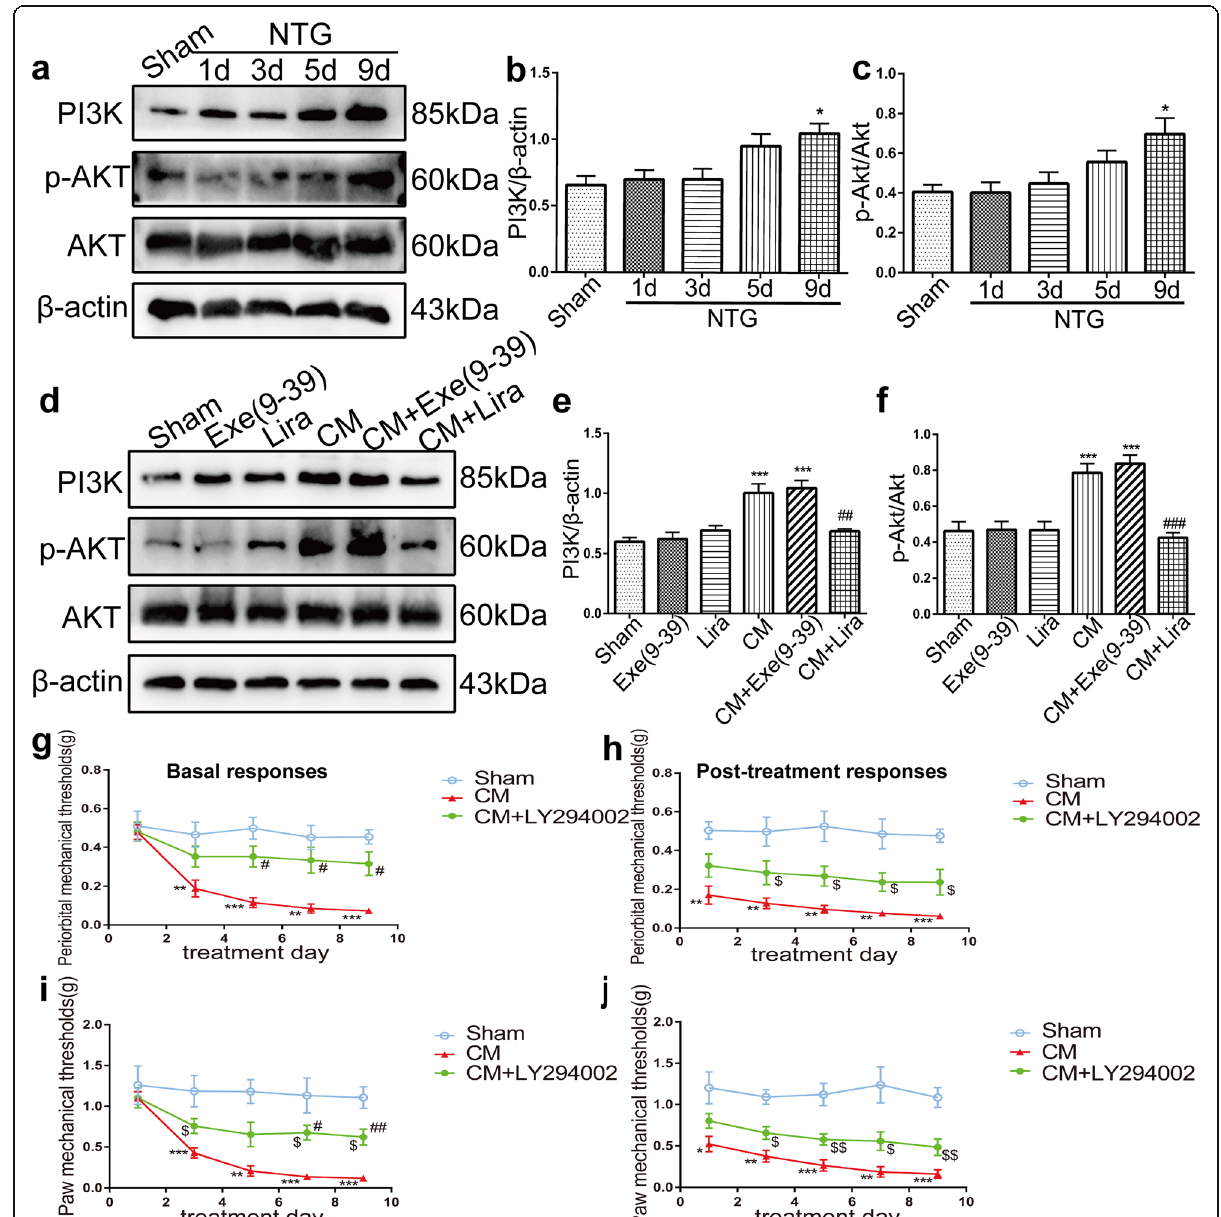
Fig. 8 Inhibition of PI3K/Akt pathway activity, which is regulated by GLP-1R, prevented NTG-induced allodynia. a-c Representative immunoblots of PI3K and p-Akt (Ser473) in the TNC on different days following NTG injection. The band intensities of PI3K and p-Akt are presented relative to those of β -actin and total Akt, respectively. Quantitative analysis revealed a dramatic increase on day 9 after NTG administration. Data are presented as mean ± SEM; n = 6/group; * p < 0.05 vs. sham group. d-f Representative western blots showing the changes in PI3K and p-Akt (Ser473) protein expression in the TNC after liraglutide and exendin(9 – 39) treatment. The results showed that activation of GLP-1R by liraglutide markedly suppressed the increase in PI3K and p-Akt in the TNC in CM mice. Data are presented as mean ± SEM; n = 6/group; *** p < 0.001 vs. the sham group; ## p < 0.01, ### p < 0.001 vs. the CM group. Repeated treatment with the PI3K selective inhibitor LY294002 partially attenuated CM- associated basal periorbital ( g ) and hindpaw ( i ) mechanical hyperalgesia. Post-treatment responses, including periorbital ( h ) and hindpaw ( j ) mechanical allodynia, were assessed 2 h following NTG injection; however, LY294002 had no significant effect on NTG-induced acute allodynia. Data are presented as mean ± SEM; n = 8/group; two-way ANOVA and Bonferroni post hoc analysis; * ,$ p < 0.05, **,$$ p < 0.01 and *** p < 0.001 The CM and CM + LY294002 groups vs. the sham group; # p < 0.05 and ## p < 0.01 vs. the CM